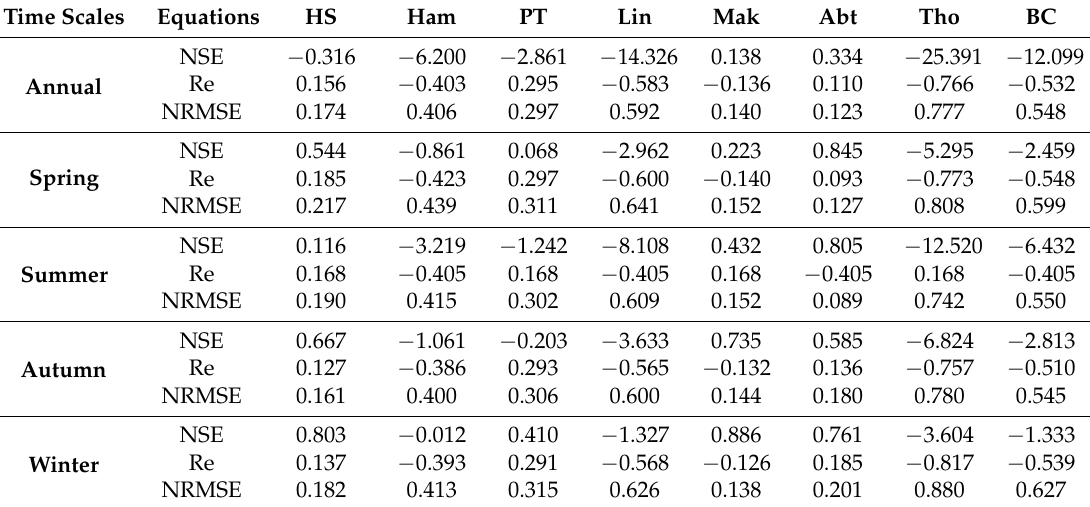
Table 4. Accuracy assessment of PET estimation in the Yun-Gui